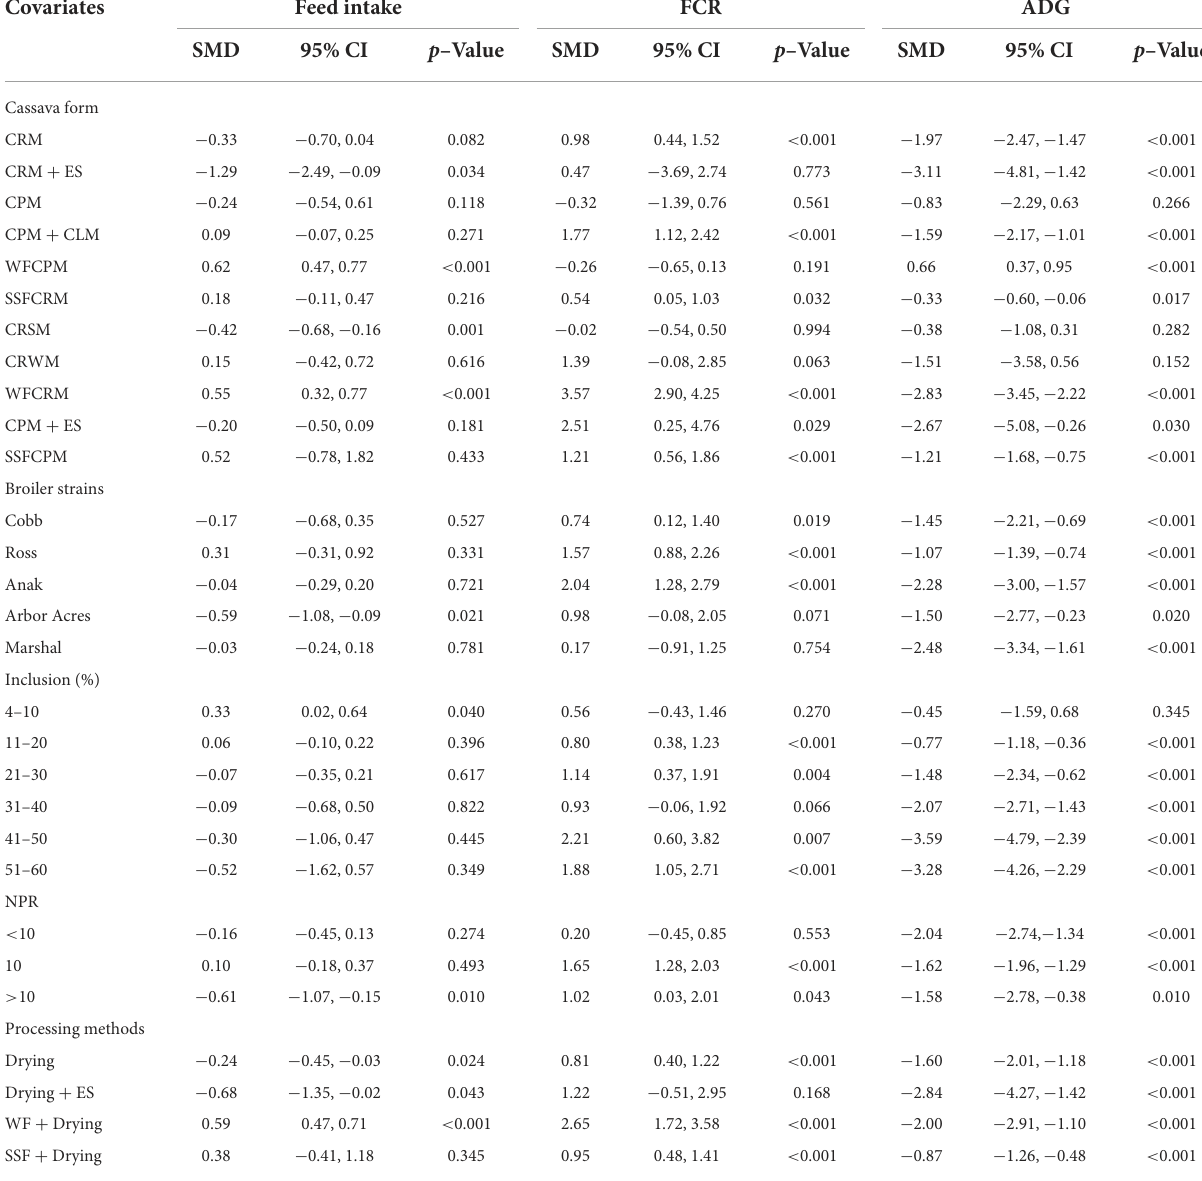
TABLE 2 Subanalysis comparing the effects of cassava on growth traits in broiler chickens. Covariates Feed intake FCR ADG SMD 95% CI p –Value p –Value Cassava